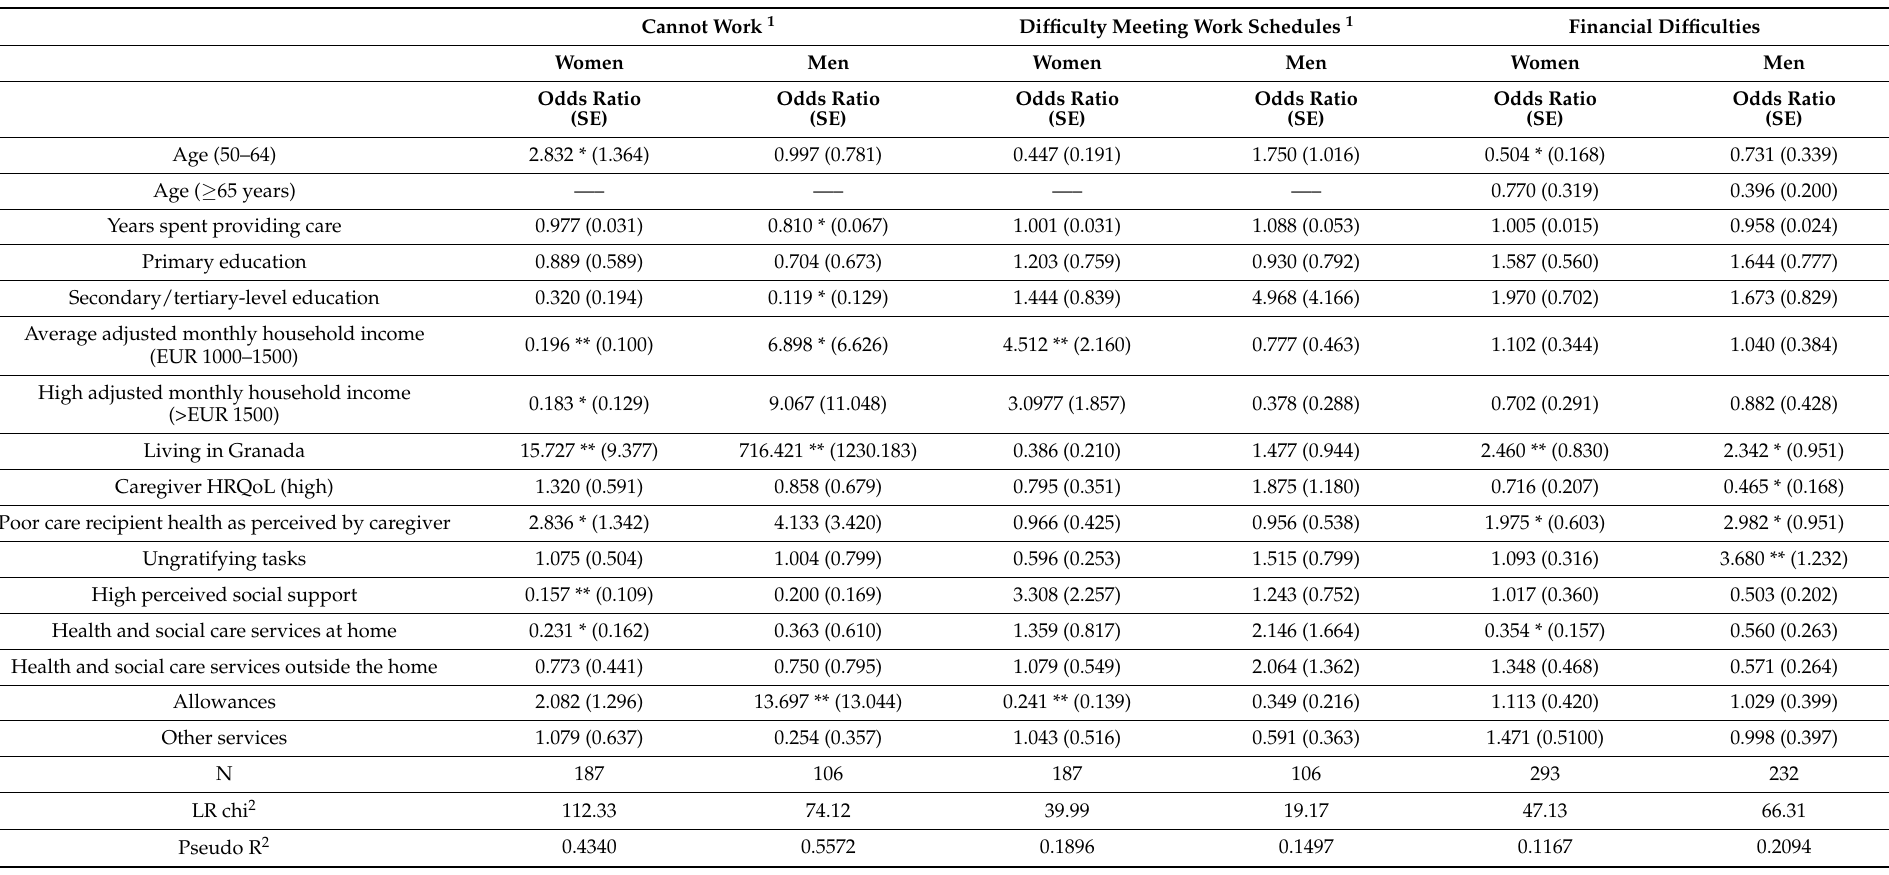
Table 5. Analysis of work and financial problems perceived by male and female